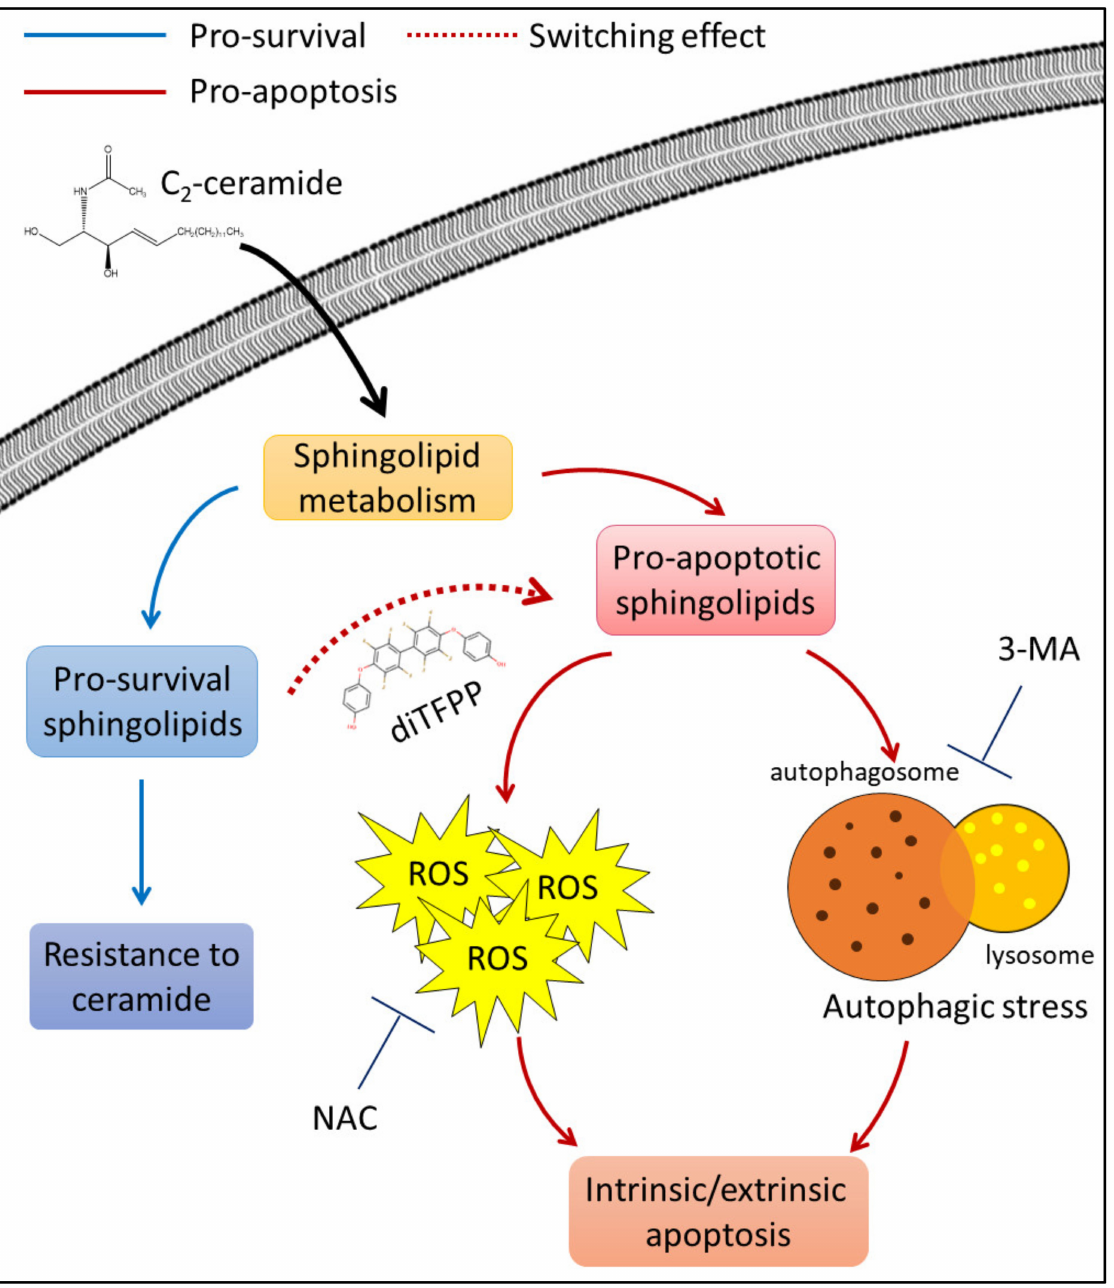
Figure 6. The potential regulatory mechanism of diTFPP in C 2 -ceramide-mediated cell death. Endogenous sphingolipid metabolism favors the conversion of exogenous C 2 -ceramide to prosurvival sphingolipids and causes the attenuation of C 2 - ceramide-induced anti-HCC effects, including anti-proliferation and apoptosis induction in HCC cells. In contrast, cotreat- ment with C 2 -ceramide and diTFPP promotes the switching of sphingolipid metabolism from prosurvival to proapoptosis, enhances ROS production and autophagic stress, and eventually sensitizes HCC cells to C 2 -ceramide-induced